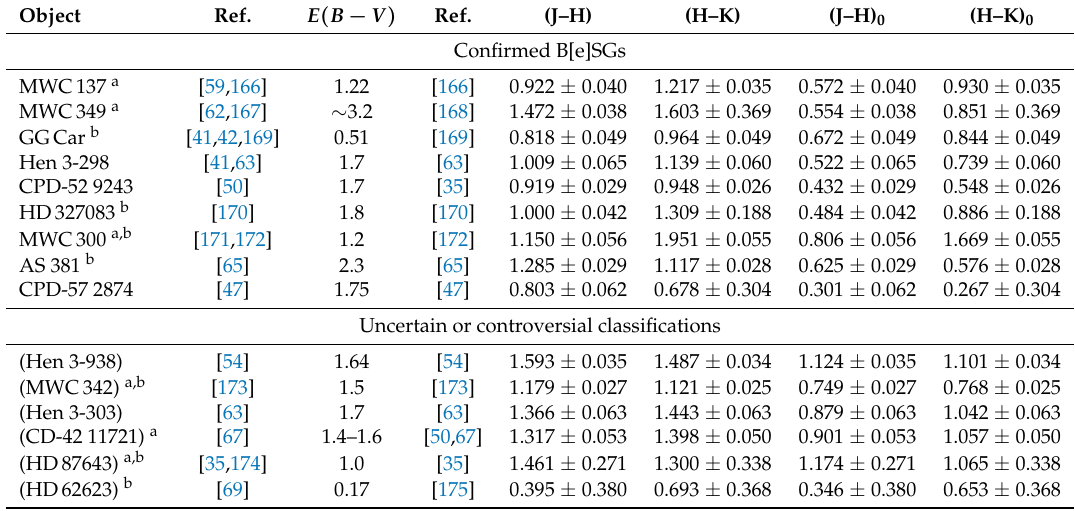
Table 9. Confirmed and candidate B[e]SGs in the Milky